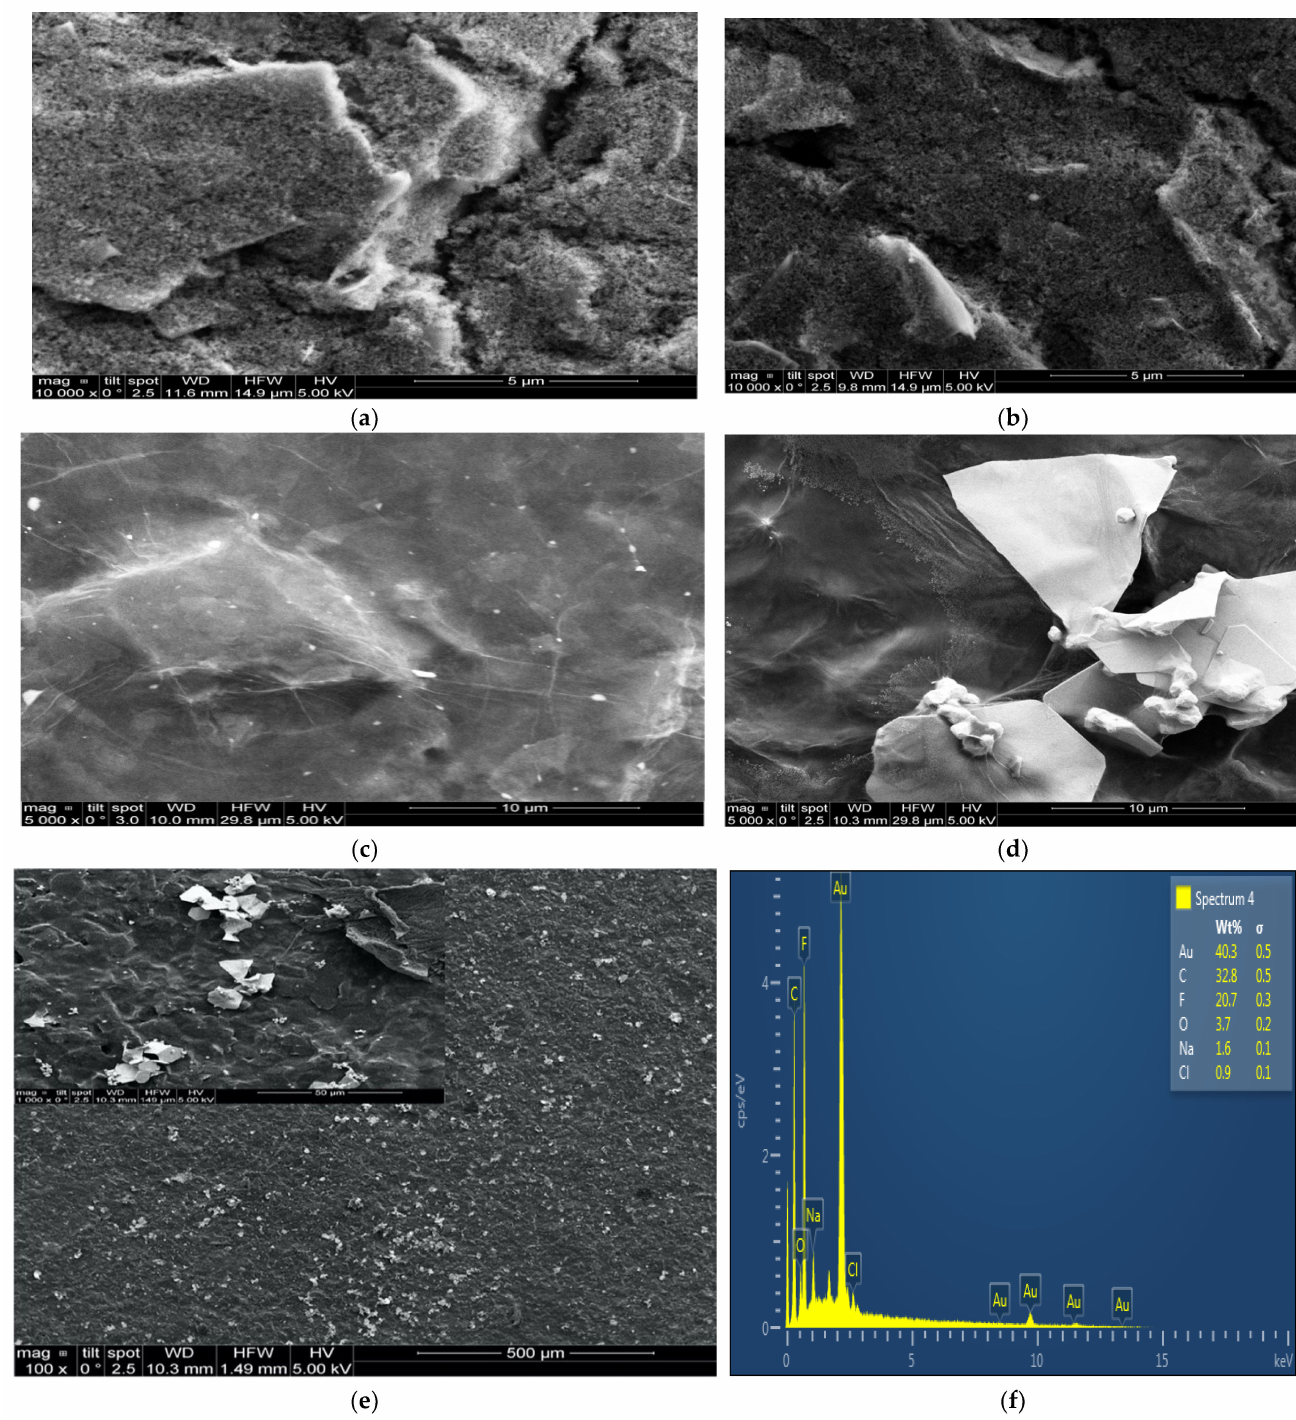
Figure 4. SEM images of bare ( a ), treated ( b ), rGO/NA ( c ) and rGO/AuNP/NA ( d ) SPCEs at 5000 magnification and ( e ) at 1000 magnification. EDX spectrum of rGO/AuNP/NA ( f